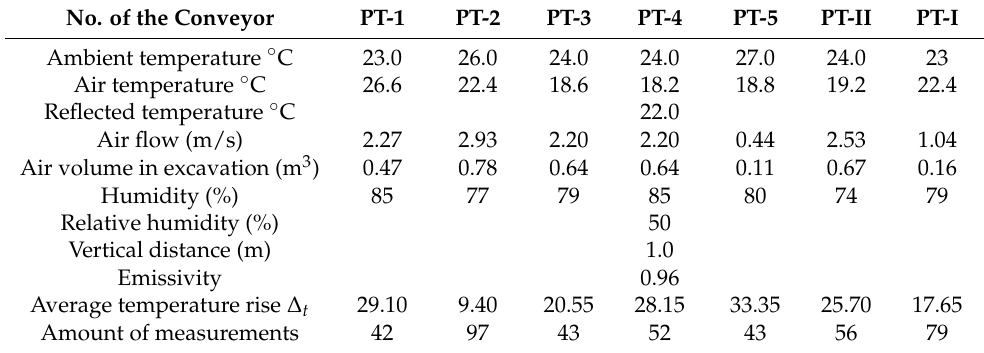
Table 4. Data obtained from measurements carried out in the surroundings of the drive unit of the main haulage belt